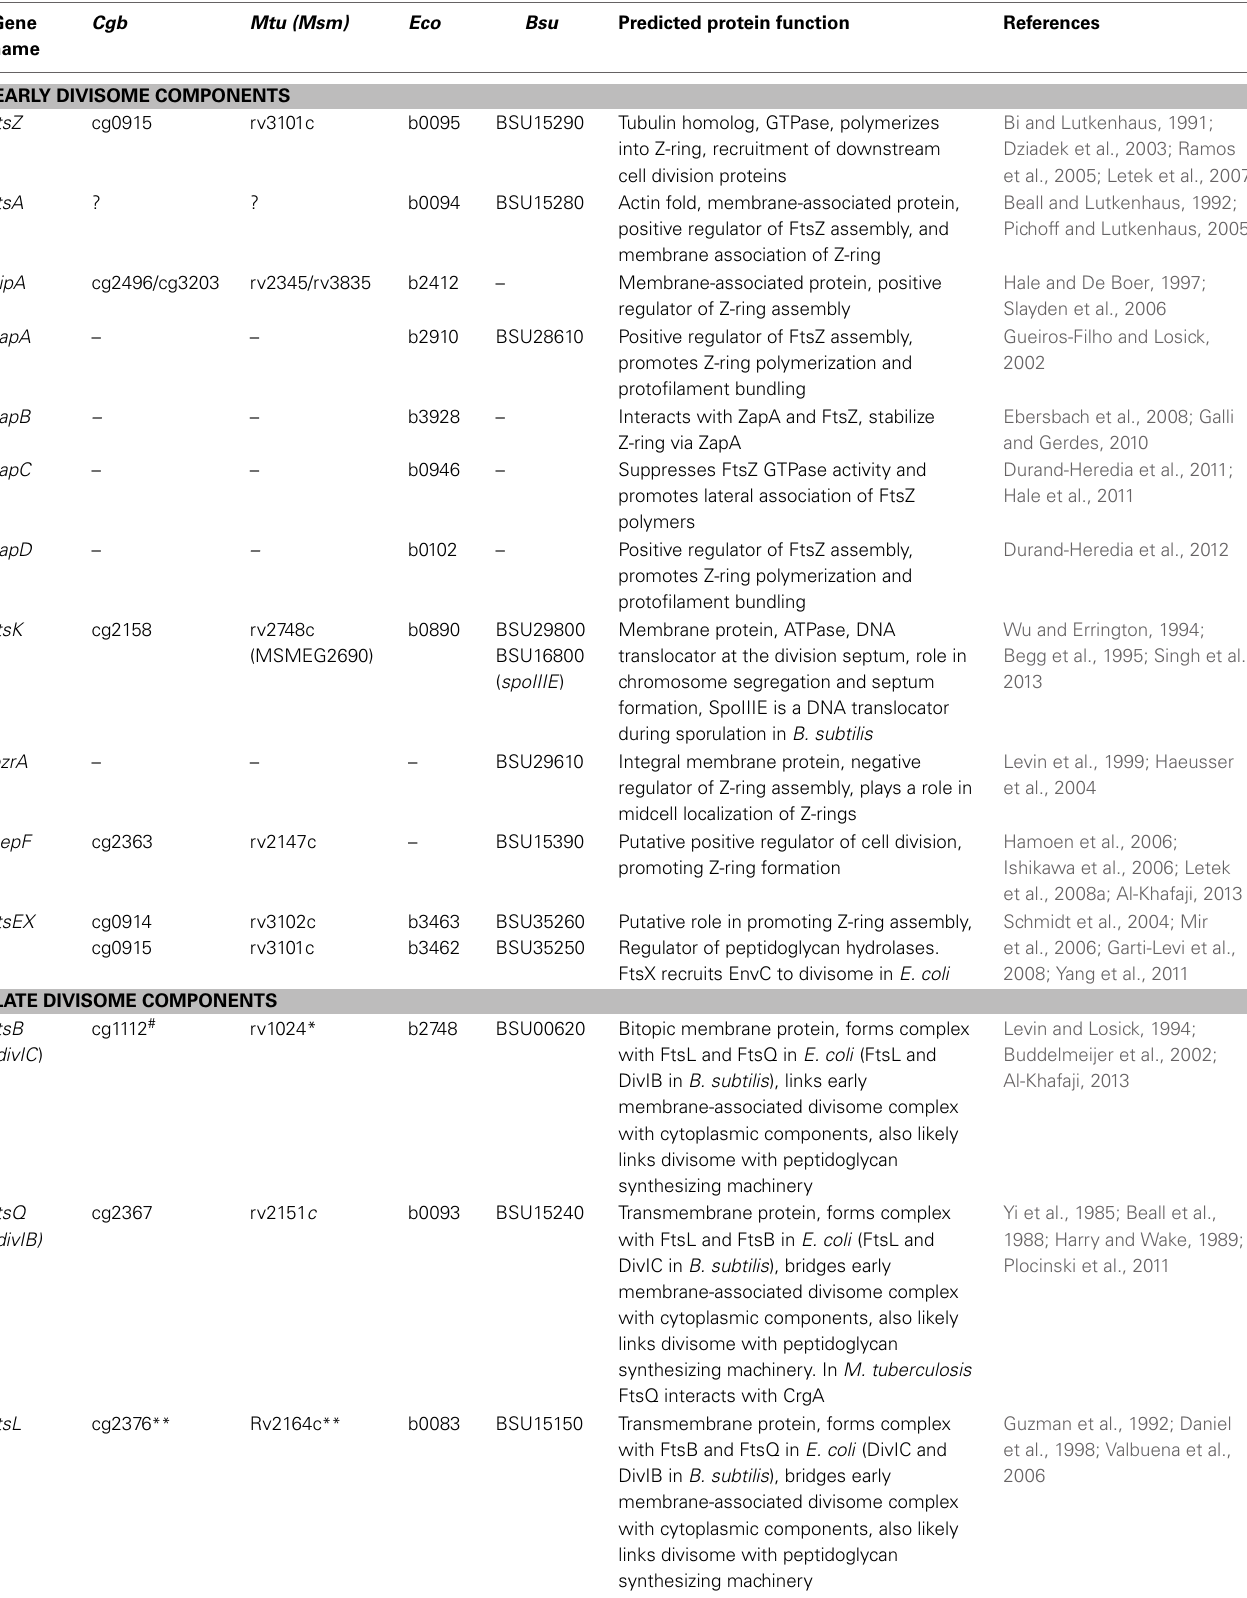
Table 1 | Putative cell division gene of C. glutamicum (Cgb), M. tuberculosis (Mtu) or M. smegmatis (Msm), E. coli (Eco), and B. subtilis (Bsu).